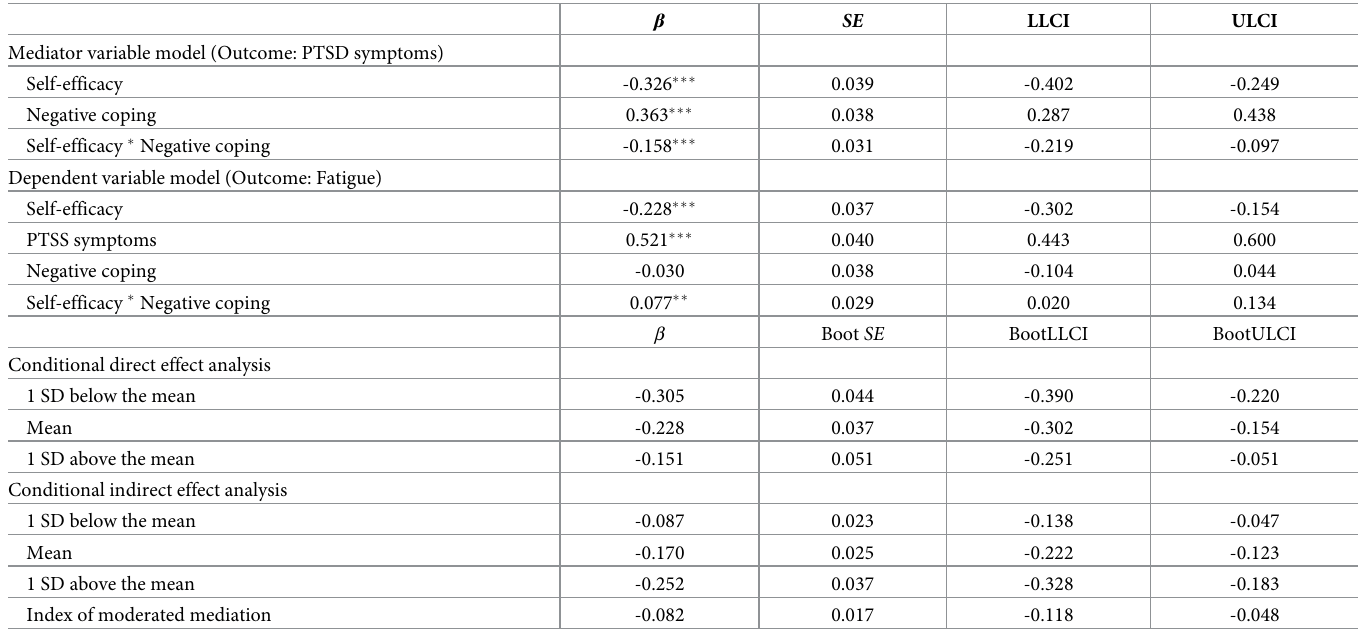
Table 4. Conditional process analysis ( N =